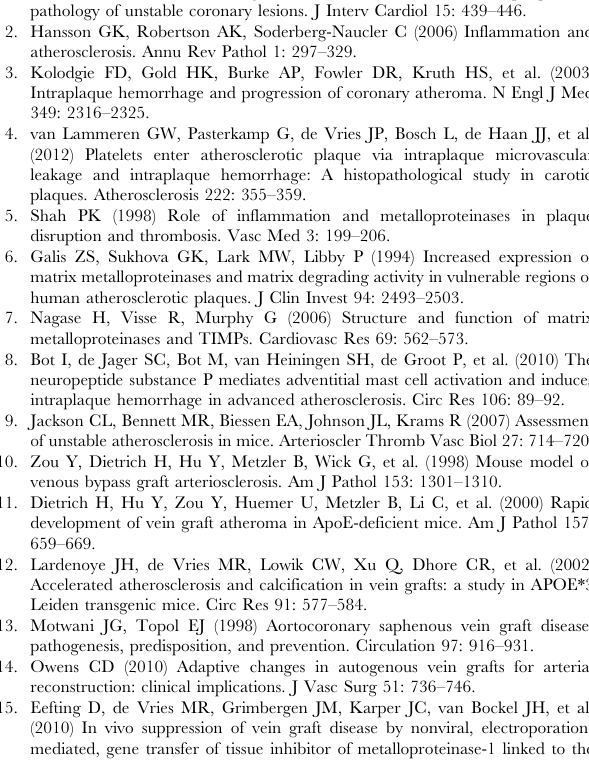
Figure S1 Immunohistochemical stainings demonstrate specific phenotypic features of vein grafts. A . 28 days after vein graft surgery an intact endothelium is present in most vein grafts. B . SMCs are found distributed throughout the whole vein